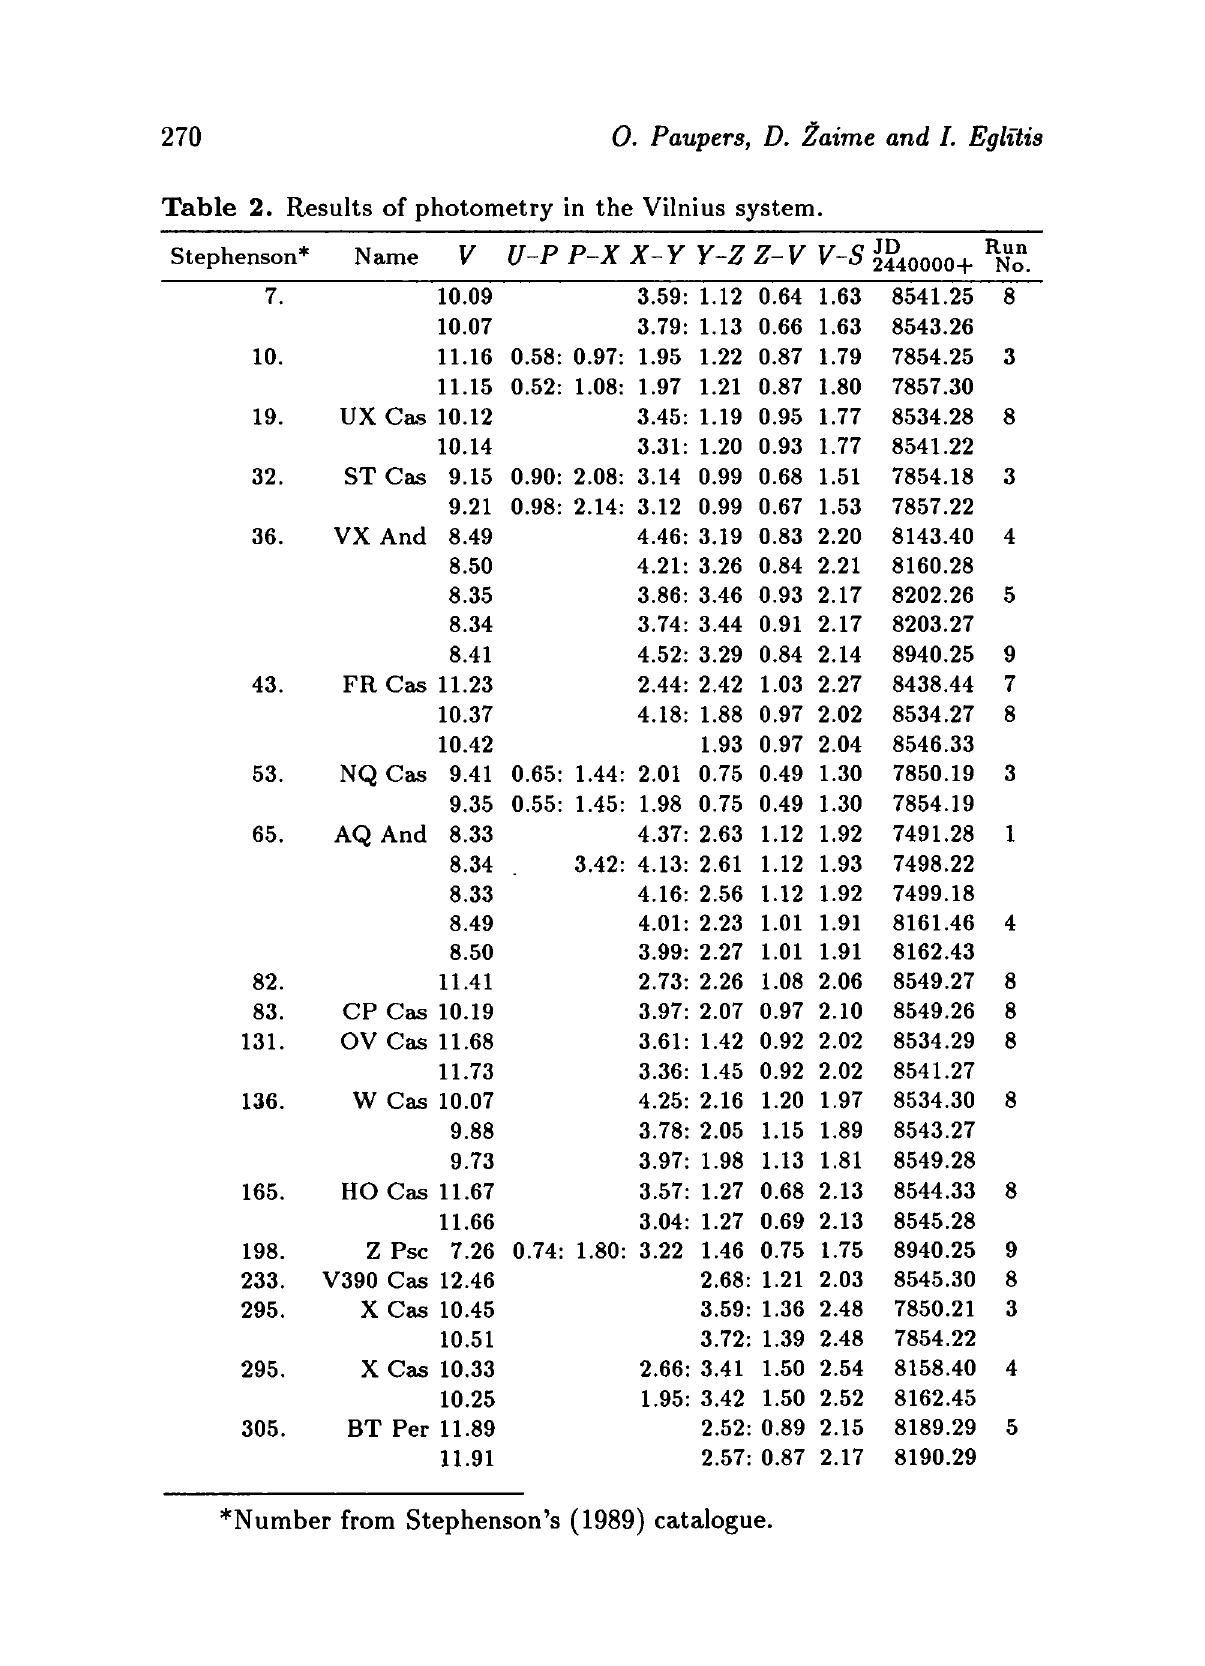
Table 2. Results of photometry in the Vilnius